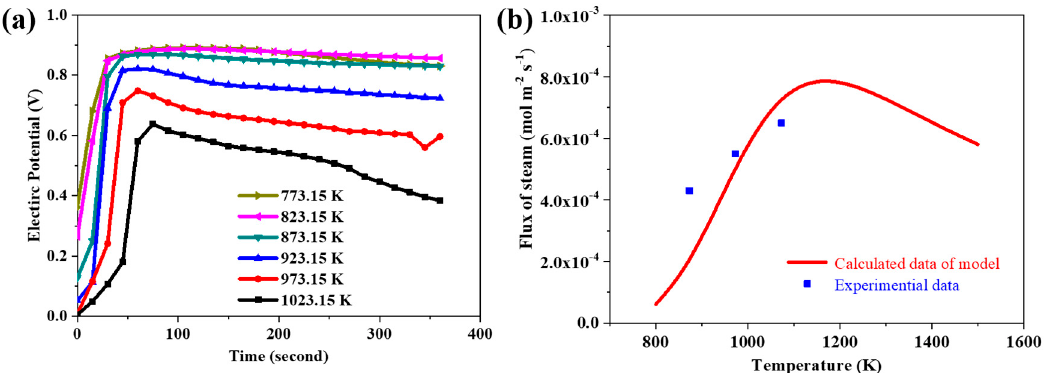
Figure 9. ( a ) The curves of the di ff erence of electric potential between both sides as a function of time at di ff erence temperatures; and ( b ) the steam flux variation through the membrane at di ff erent temperatures.